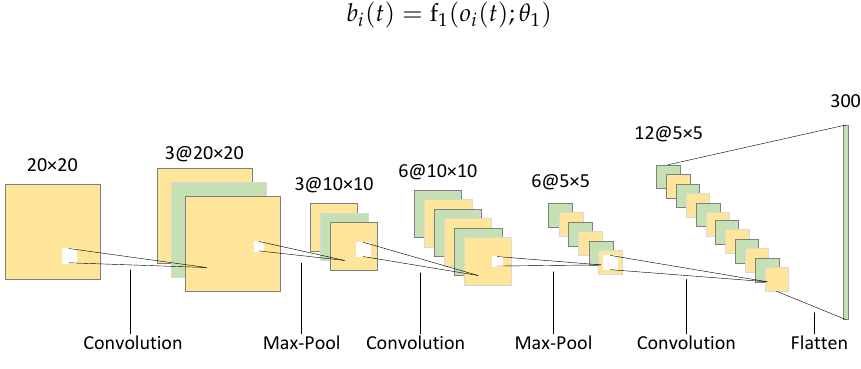
Figure 4. The structure of the convolutional neural network.